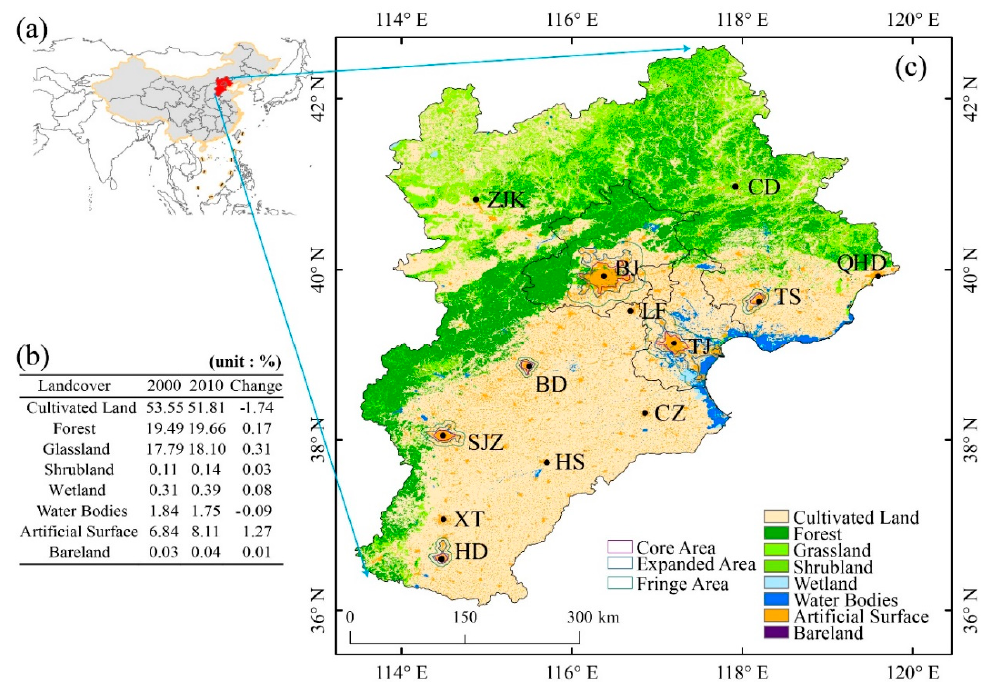
Figure 1. Location and land cover of the research area. ( a ) The location of the Beijing–Tianjin–Hebei (BTH) region in China, ( b ) the variation in land cover in the BTH region, and ( c ) the distribution of land use types. Beijing (BJ), Tianjin (TJ), Shijiazhuang (SJZ), Handan (HD), Tangshan (TS), Baoding (BD) Zhangjiakou (ZJK), Xingtai (XT), Hengshui (HS), Cangzhou (CZ), Langfang (LF), Chengde (CD), and Qinghuangdao (QHD) refer to 13 cities in the BTH region.